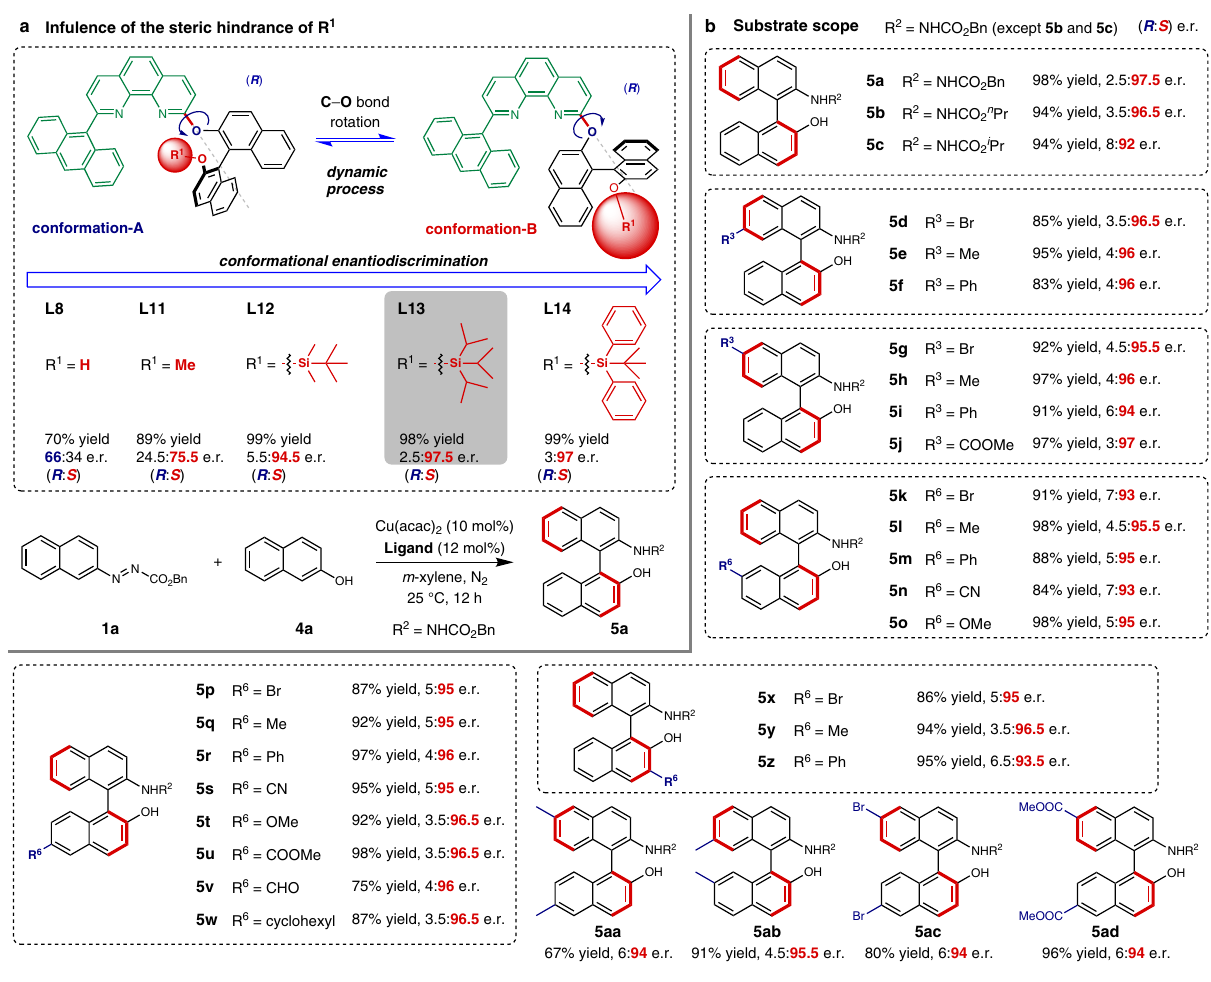
Fig. 3 | Conformational enantiodiscrimination for the asymmetric cross- coupling of azonaphthalenes with 2-naphthols. a In fl uence of the conforma- tional equilibrium on enantiodiscrimination. b Substrate scope. Reaction condi- tions: 1 (0.10mmol), 4 (0.12mmol),Cu(acac) 2 (10mol%),ligand(12mol%), m -xylene